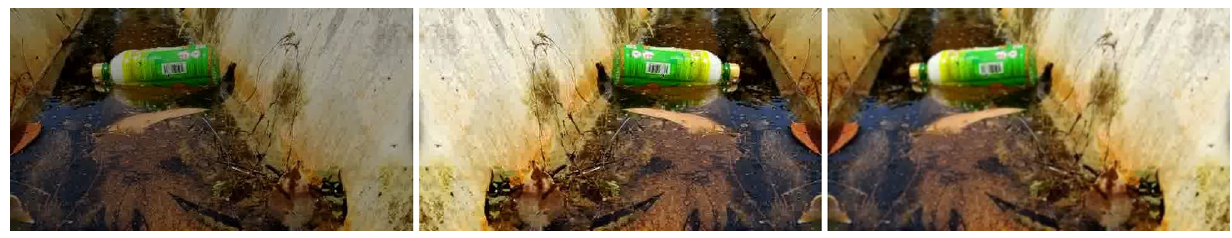
Figure 8. Data-augmentation of one input